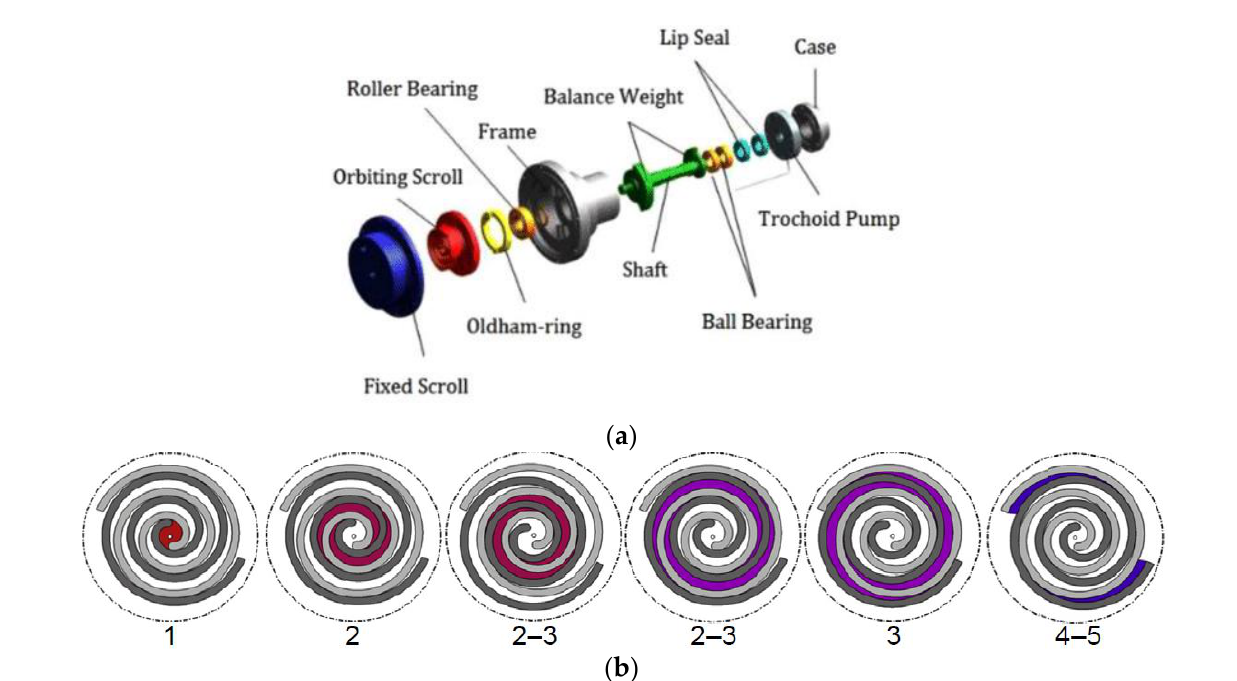
Figure 12. Two-phase scroll expander, with geometry ( a ) [12] and principle of operation ( b ) [10].